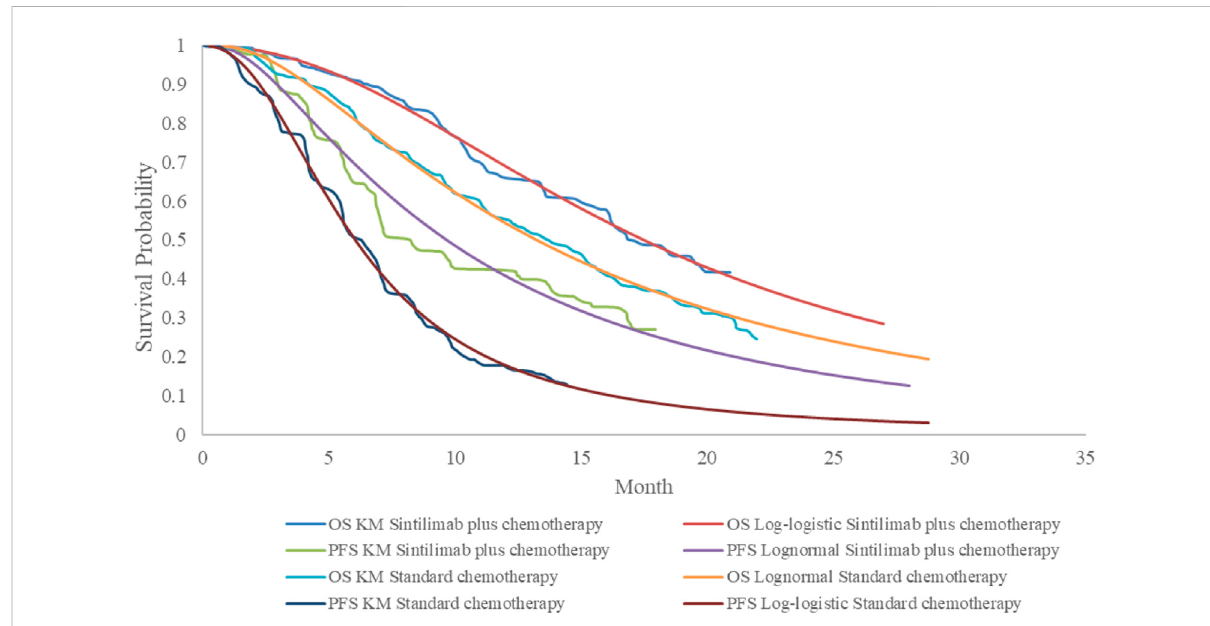
FIGURE 3 Estimated survival curves for progression-free survival and overall survival in patients with CPS ≥ 10 derived from the ORIENT-15 trial.